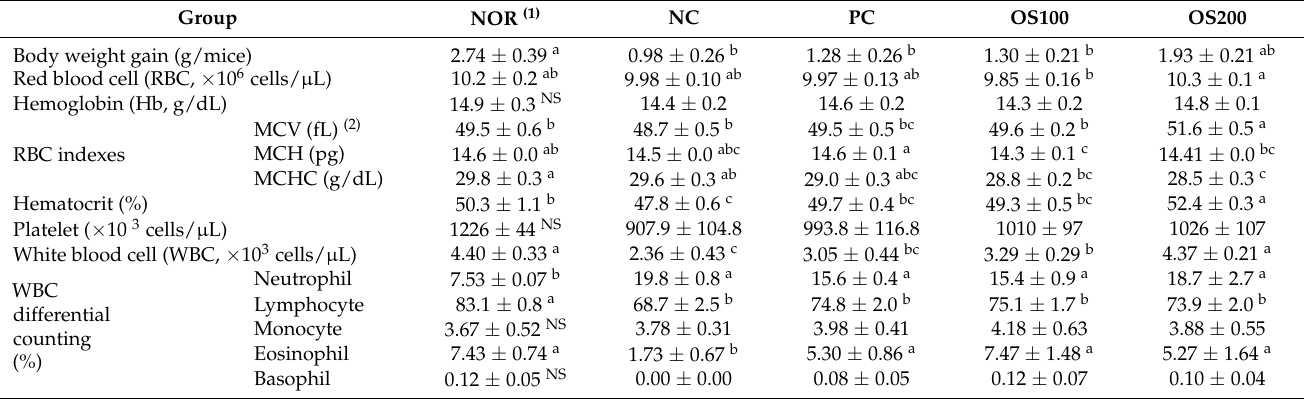
Table 5. Effects of A. cepa skin (OS) extracts on the body weight gain and hematological factors in C57BL/6 mice immunosuppressed by